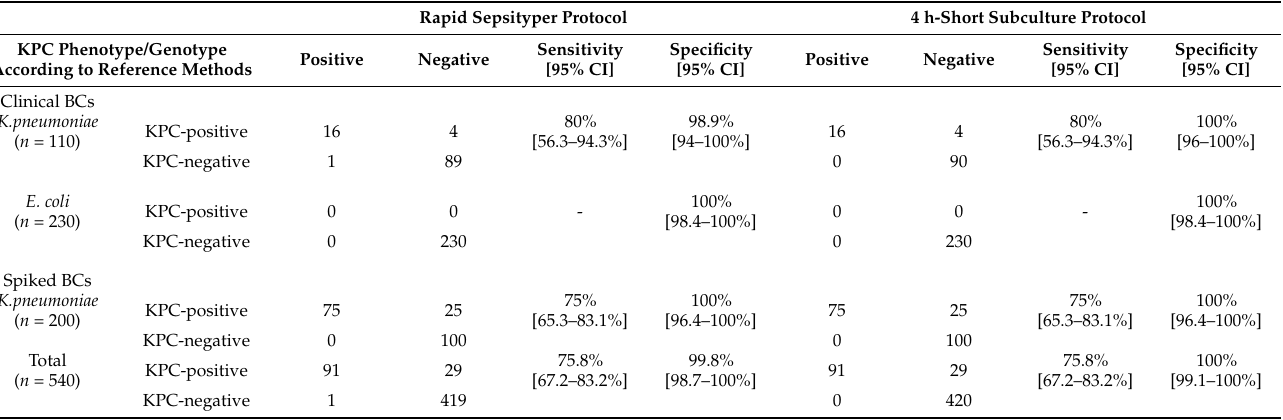
Abbreviations: CI, confidence interval; BCs, blood